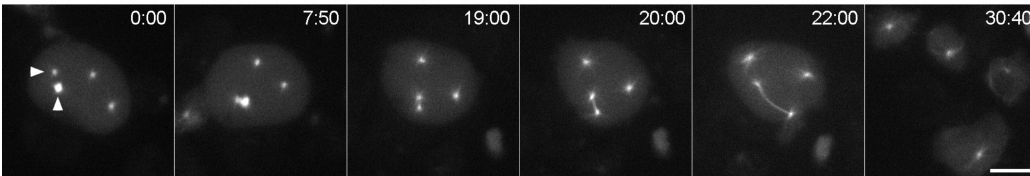
Figure 5. Spindle formation in presence of multiple centrosomes. Live cell sequence shows a mononucleated cell that contained two centrosomes prior to entering mitosis. In the first panel (time = 0:00, m:s), both centrosomes have duplicated and separated into four daughters, but only one daughter of the pair indicated with arrowheads contacts the nucleus (distinguished here because of the increase in GFP-tubulin fluorescence). By 7:50, the other daughter binds to the nucleus and the two centrosomes then cooperate to form a bipolar spindle. In this cell, all four centrosomes triggered cytokinetic furrows, cleaving the cell into two normal cells with nuclei and two cytoplasts (30:40). Scale bar = 5 µ